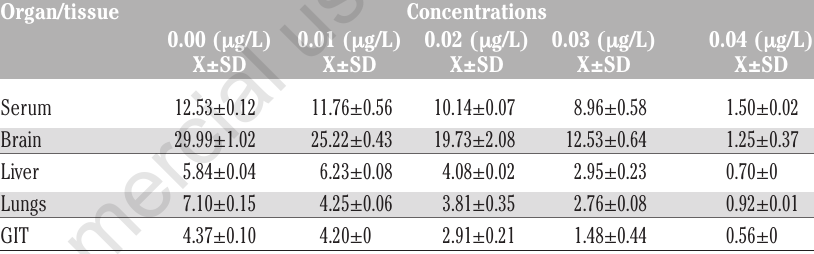
Table 1. Acetylcholinesterase activities (umg –1 protein) in tissues of Bufo regularis exposed to diazinon for 28 days (mean±SD). Organ/tissue